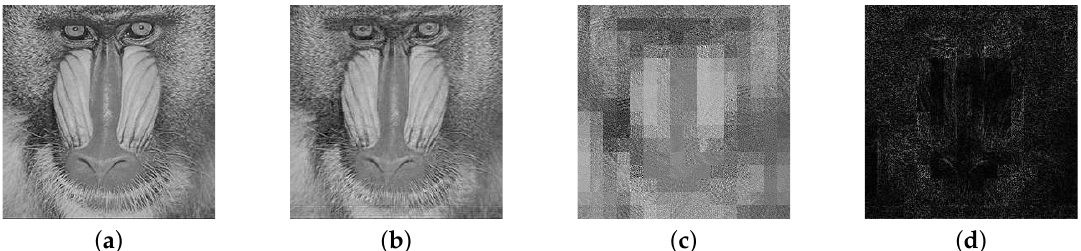
Figure 6. Key sensitivity in the decryption part. ( a ) Plain image of a baboon; ( b ) decrypted image with correct secret key; ( c ) decrypted image with wrong secret key; ( d ) difference between two decrypted images.